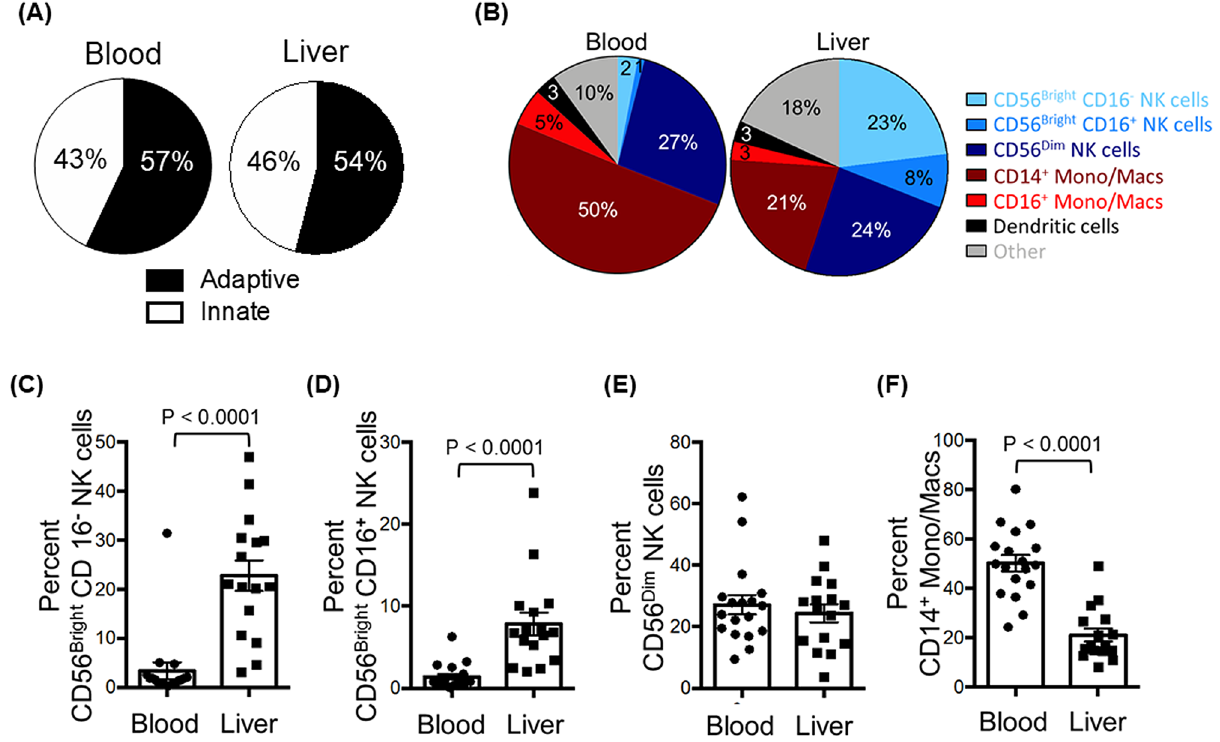
Figure 2. Comparison of the abundance of innate immune cells in the liver and in peripheral blood. (A) Pie charts depicting the composition of innate and adaptive immune cells from peripheral blood (left) and liver (right). (B) Pie charts depicting the composition of CD45 + lineage negative (CD3 - , CD19 - , CD20 - ) innate immune populations of the peripheral blood (left) and liver (right). (C) The percentage of CD56 Bright CD16 - NK cells of total hematopoietic (CD45 + ), lineage negative (CD3 - , CD19 - , CD20 - ) cells from liver and peripheral blood mononuclear cells. (D) The percentage of CD56 Bright CD16 + NK cells. (E) The percentage of CD56 Dim CD16 + NK cells. (F) The percentage of CD14 + monocytes/macrophages. Horizontal bars depict the mean ± SEM. N = 16 liver leukocytes, n = 18 PBMCs by unpaired t